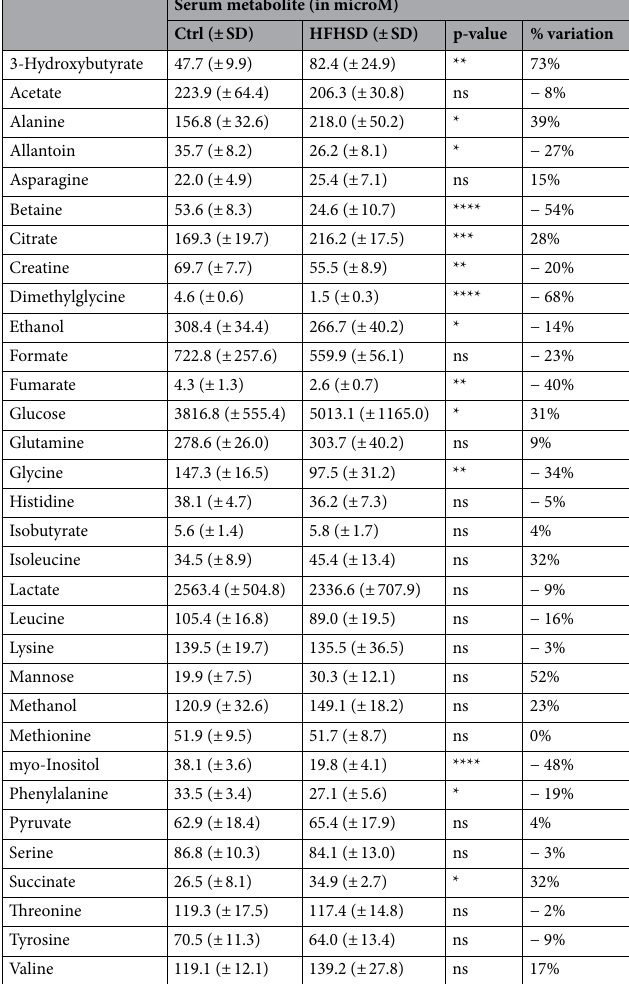
Table 3. Metabolite concentrations measured by NMR in the serum of SD and HFHSD mice. Results are expressed as mean ± standard deviation (SD) and are in micromolar in serum. Data are mean of n = 8 mice per group; Results of unpaired two-tailed t-test are indicated as non-determined (ND), non-significant (NS), p < 0.05 (*), p < 0.01 (**), p < 0.001 (***) and p < 0.0001 (****). Percentages of variation between HFHSD and control fed mice are